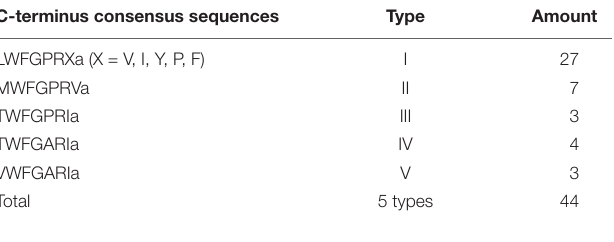
TABLE 1 | DH-like neuropeptides classified into five types by C-terminus consensus